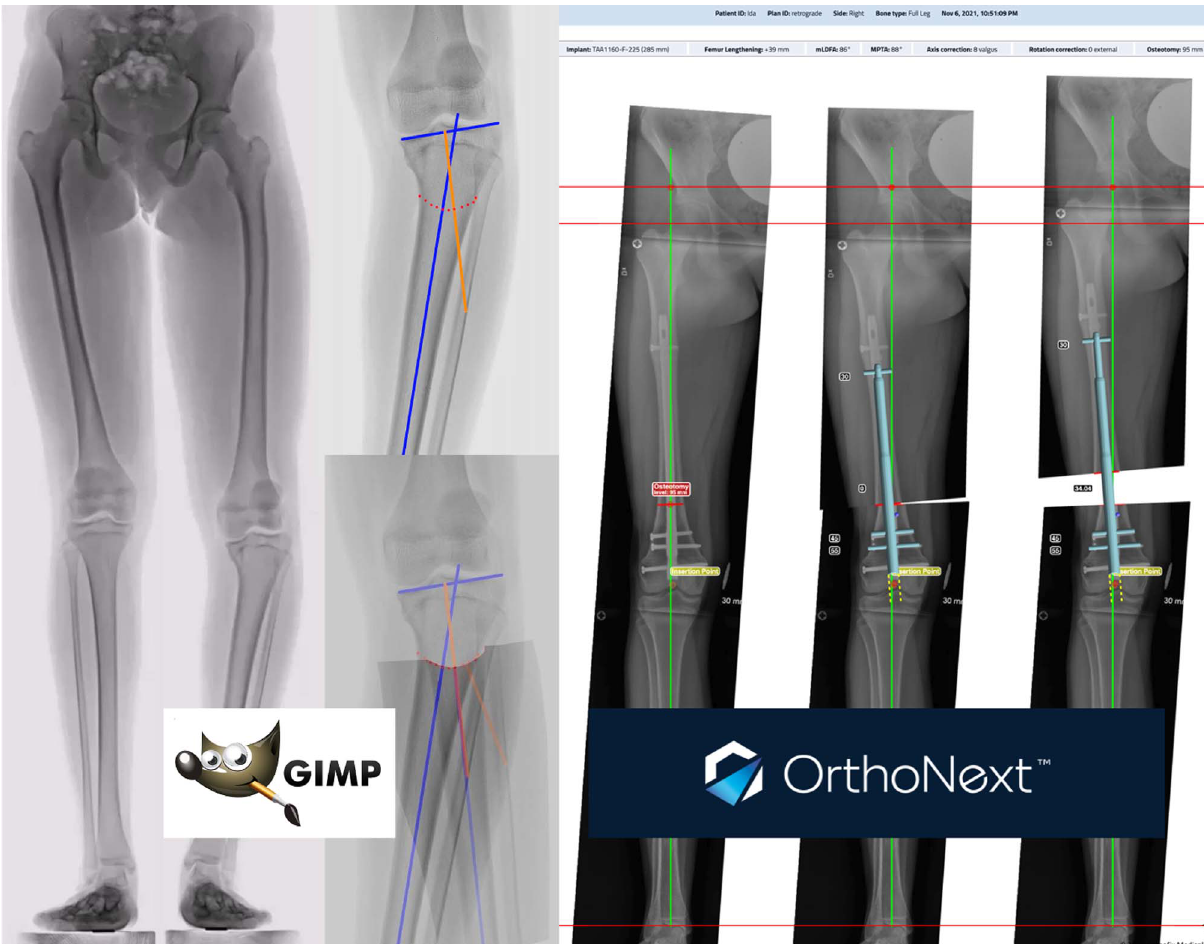
Figure 3. Software for deformity analysis and correction . GIMP is free, open-access imaging software. OrthoNext is also free and semi-